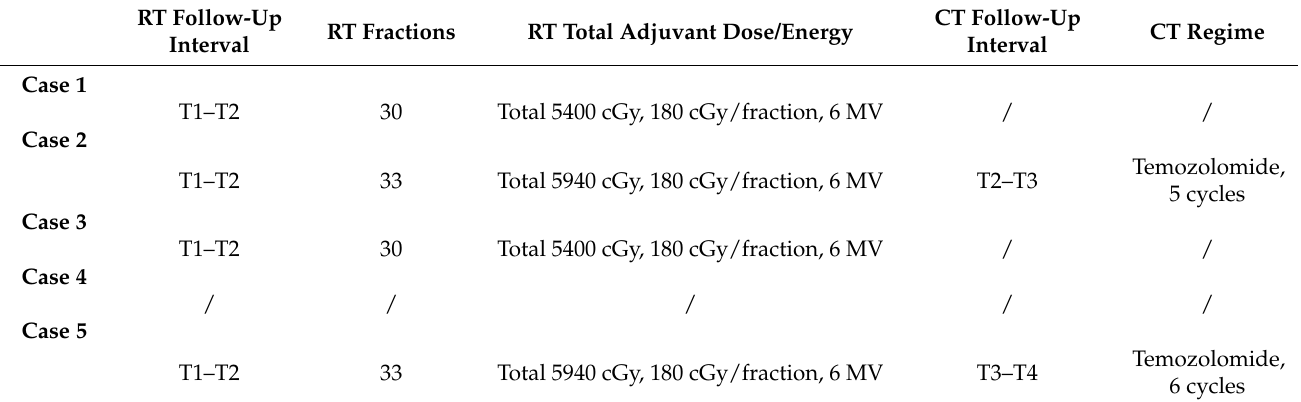
Table 2. Treatment received by our patients during the follow-up